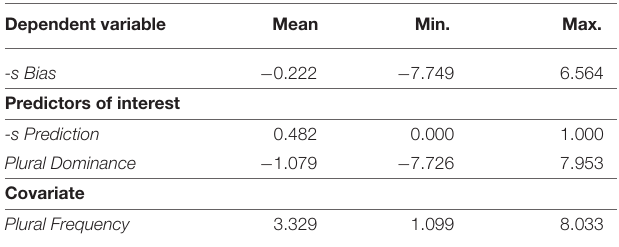
TABLE 1 | Mean, minimum and maximum values of the variables in the distributional